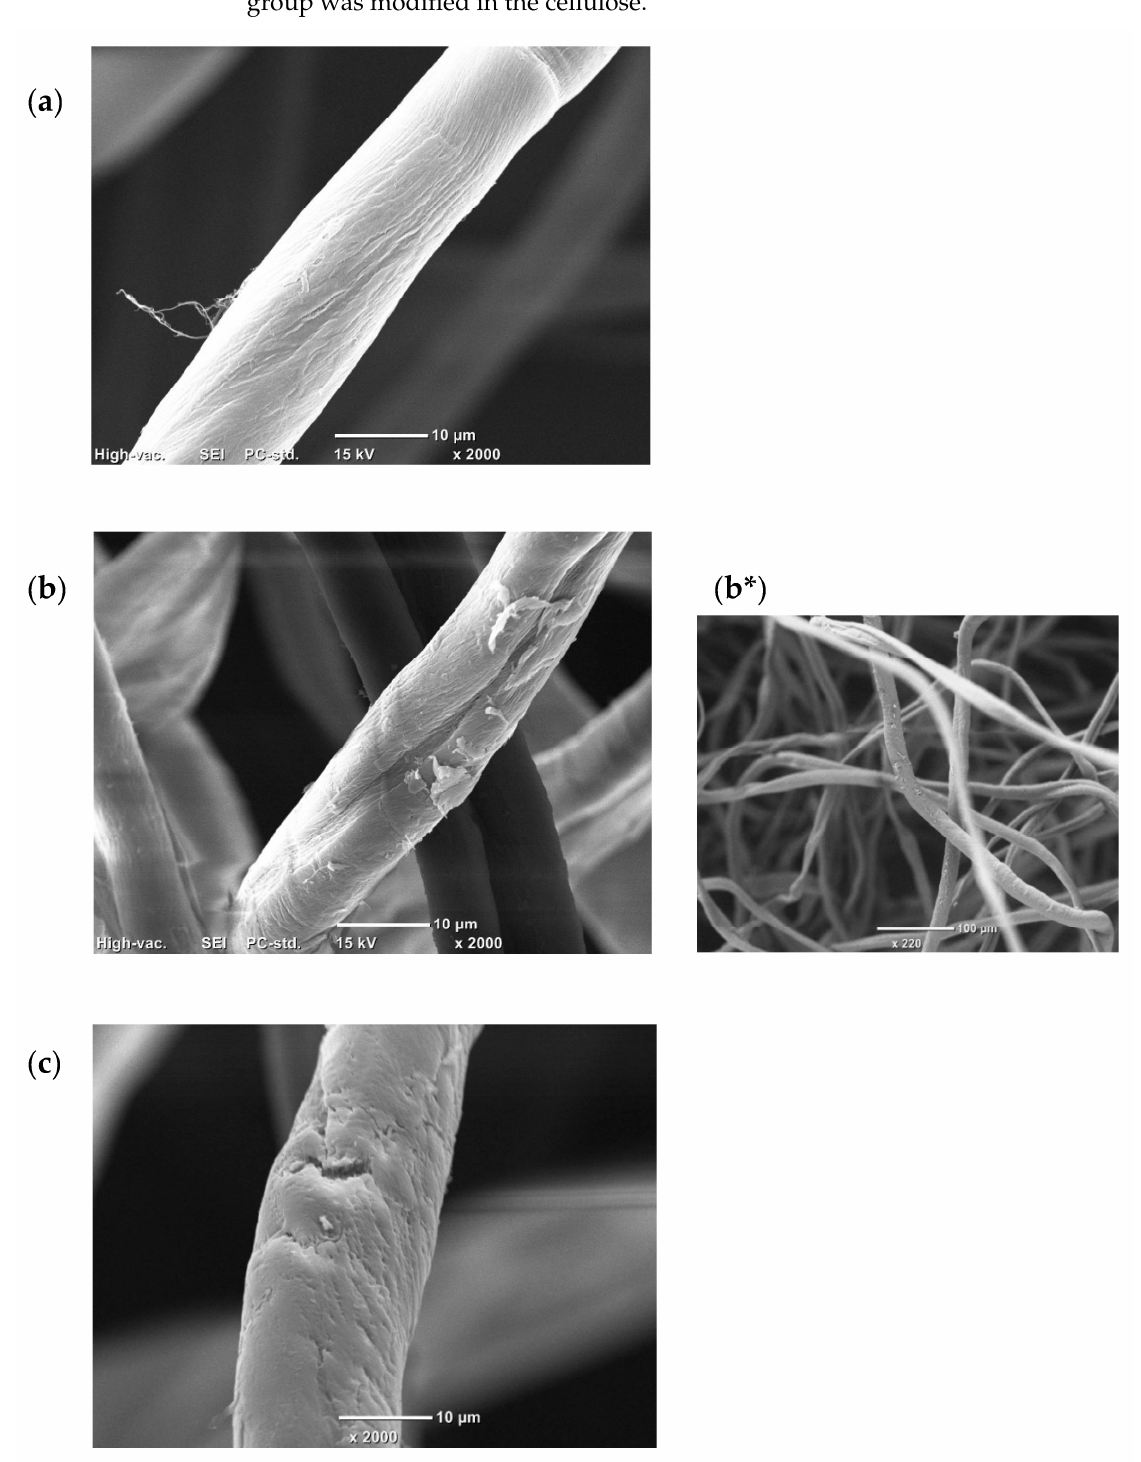
Figure 5. SEM image of ( a ) the pure cellulose (×2000), ( b ) the modified cellulose (×2000) [( b* ) (×220)], ( c ) the adsorbed cellulose (×2000).